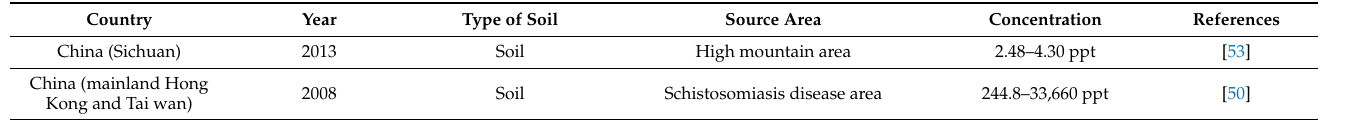
Table 1. The average concentration of dioxins (homogeneous unit calculated in ppt TEQ in dry weight) in some different nations in